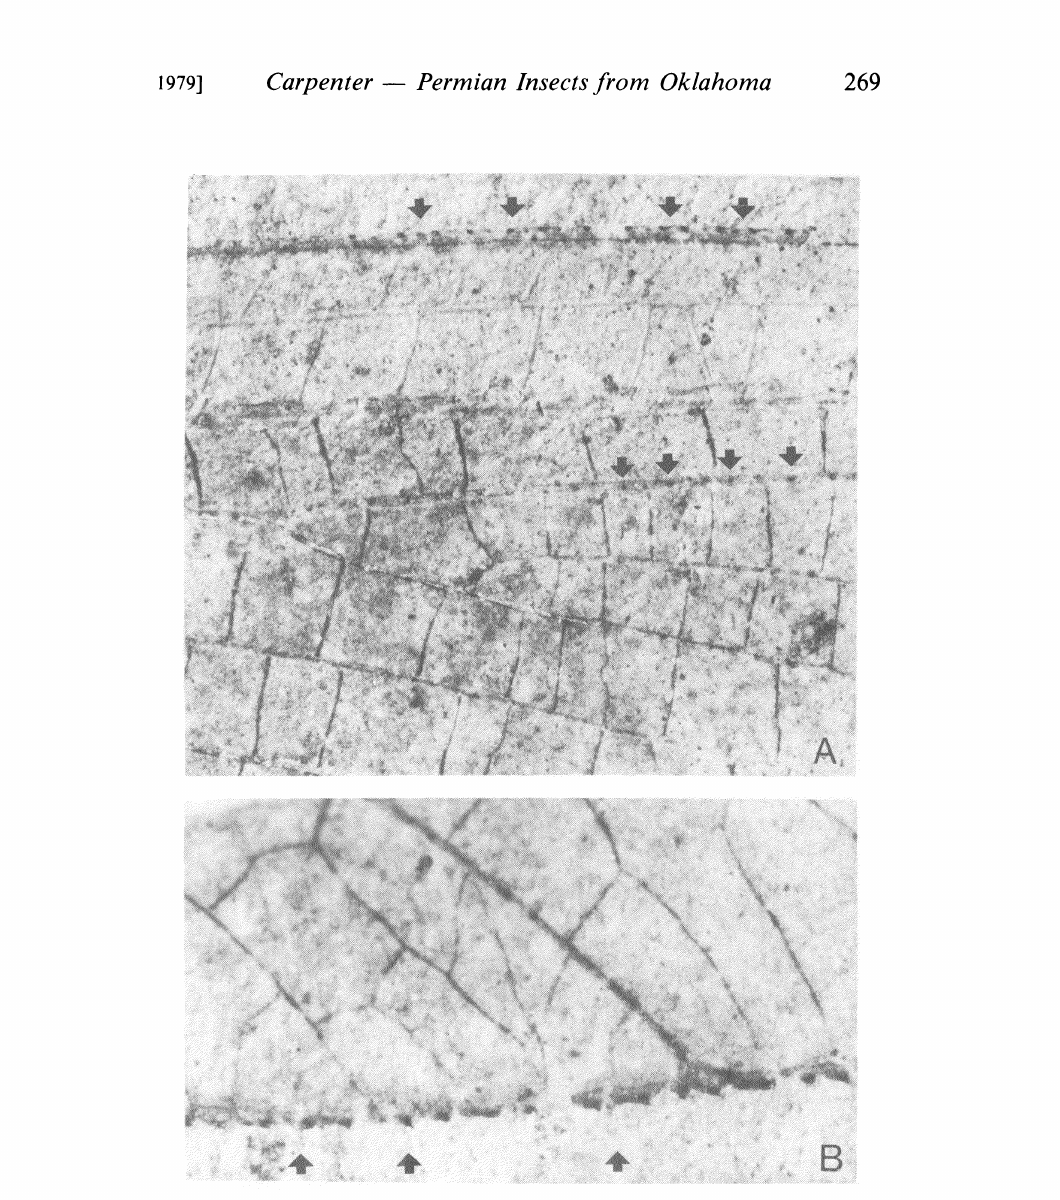
Figure 5. Protereisma latum Sellards. Photographs of neotype, MCZ 3419a, from Permian of Kansas, showing: A, anterior part of hind wing, the arrows pointing to setal bases along the front margin of the wing and on certain veins ( 24); B, posterior part of same wing, the arrows pointing to the serrated hind margin